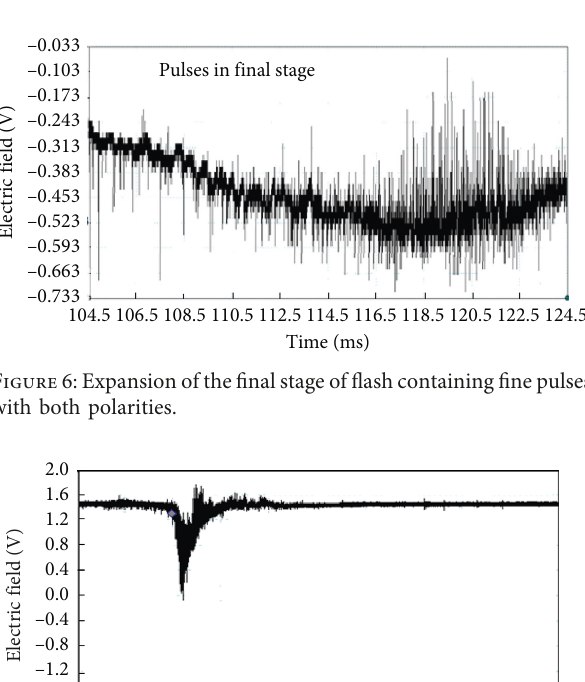
Figure 5: Expansion of initial (or active) stage of flashes from Figure 4 with negative initial polarity.